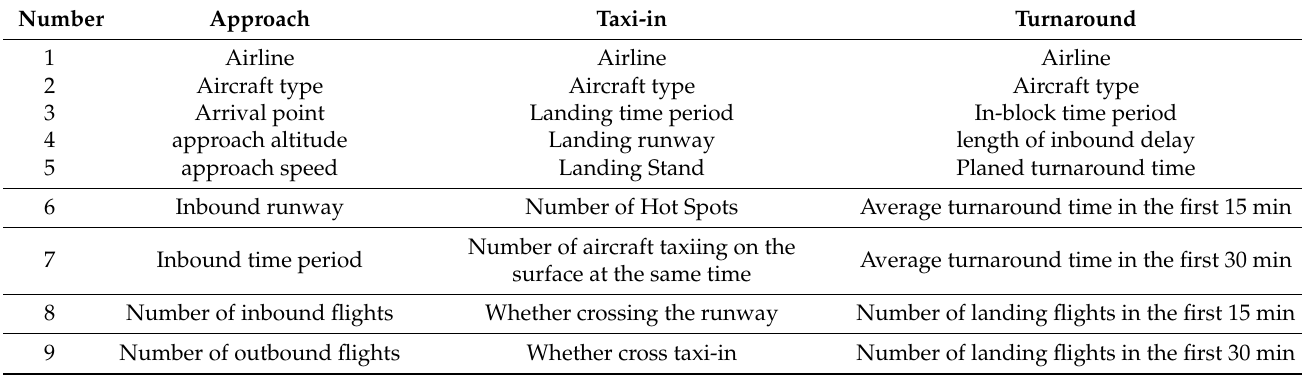
Table 3. The set of influencing factors of the three links.